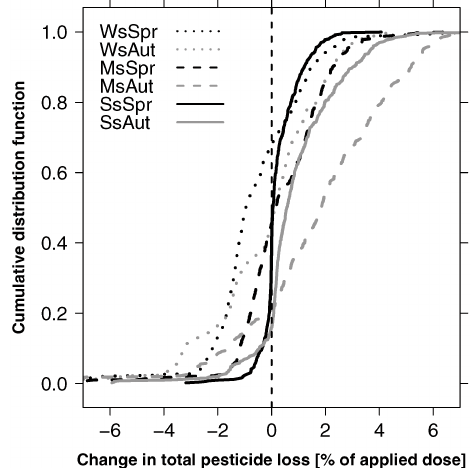
Fig. 6. Cumulative distribution functions of the ensemble predic- tions of the changes in pesticide leaching losses from present to fu- ture for the six pesticide application scenarios (as in Table 3). Each curve combines all 56 acceptable parameterizations of the pesticide fate model and the nine different climate scenarios. Spring applica- tions are represented with black lines and autumn applications with grey lines. Dotted lines represent weakly sorbed pesticides; dashed lines represent moderately sorbed pesticides; solid lines represent strongly sorbed